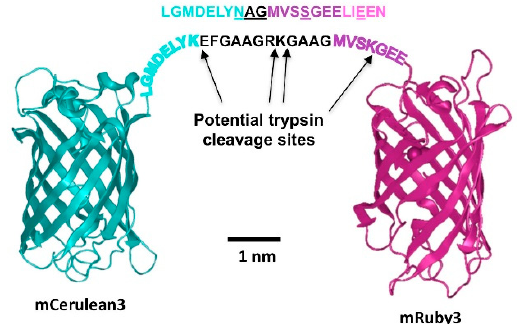
Figure 2. mCerulean3_mRuby3 FRET fusion construct. The proteins are represented based on the reported crystal structures of their closest relatives (5oxb for Cerulean [13], 3u0l for mRuby [14]). The amino acid sequence of the non-native peptide linker is shown in black print. The sequences in cyan represent the native Cerulean C-terminus that is flexible and thus not visible in the high resolution structure. The mRuby3 N-terminal flexible sequence is given in dark magenta. Potential trypsin cleavage sites in these sequences are indicated by the arrows. Above the fusion protein linker, the corresponding sequence that replaces it in the trypsin-resistant fusion protein is indicated. All positions where trypsin cleavage sites have been eliminated are underlined. The print size of the peptide sequences was chosen to occupy approximately the space of the amino acid sequence when stretched completely, and a scale bar based on the three-dimensional (3D) structure dimensions is